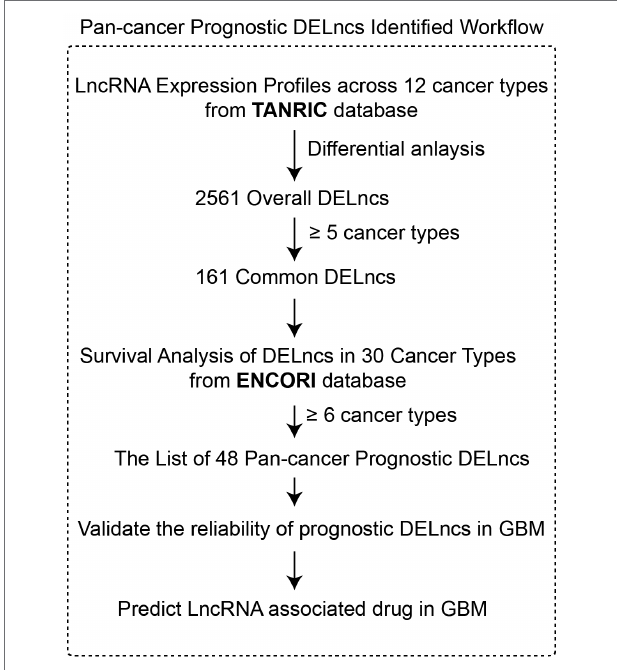
FIGURE 1 | The integrative pipeline for identification of pan-cancer prognostic